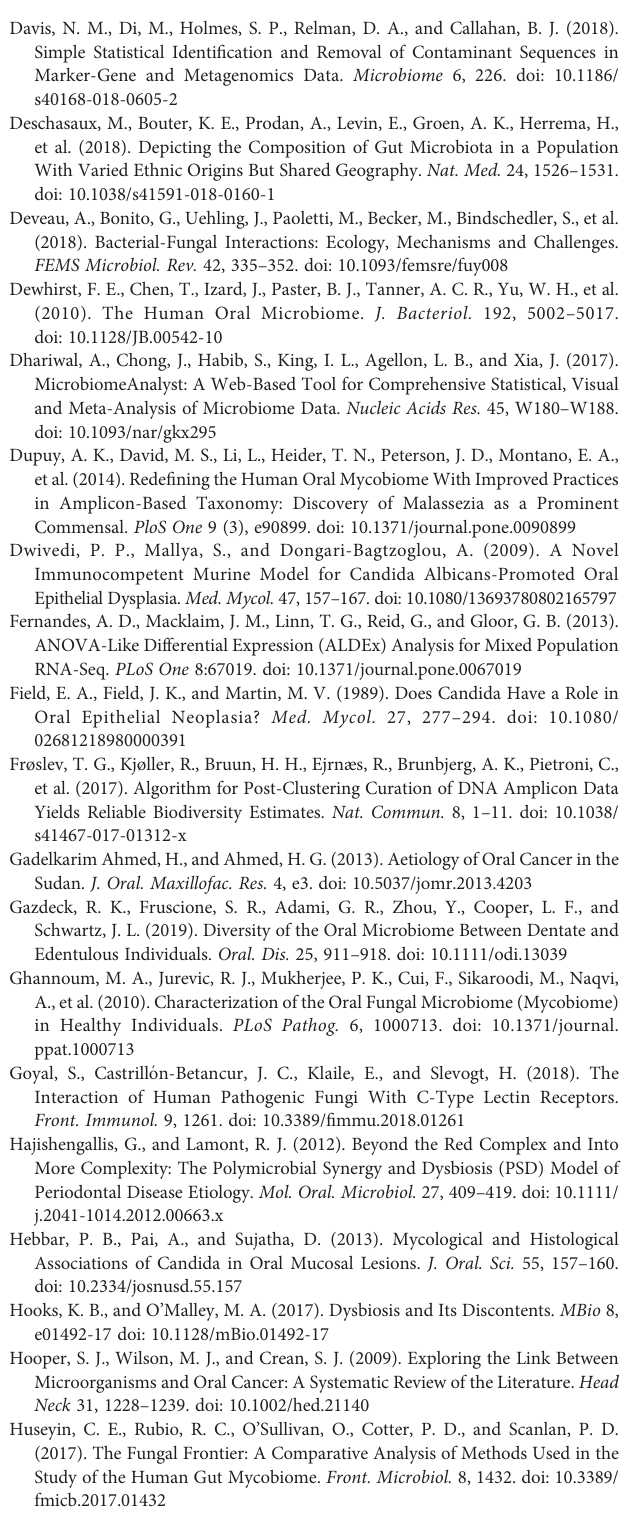
and differences in abundance of 5 topmost salivary fungi according to mean number of missing teeth. (F) Distribution and differences in abundance of 5 topmost salivary fungi according to diabetes